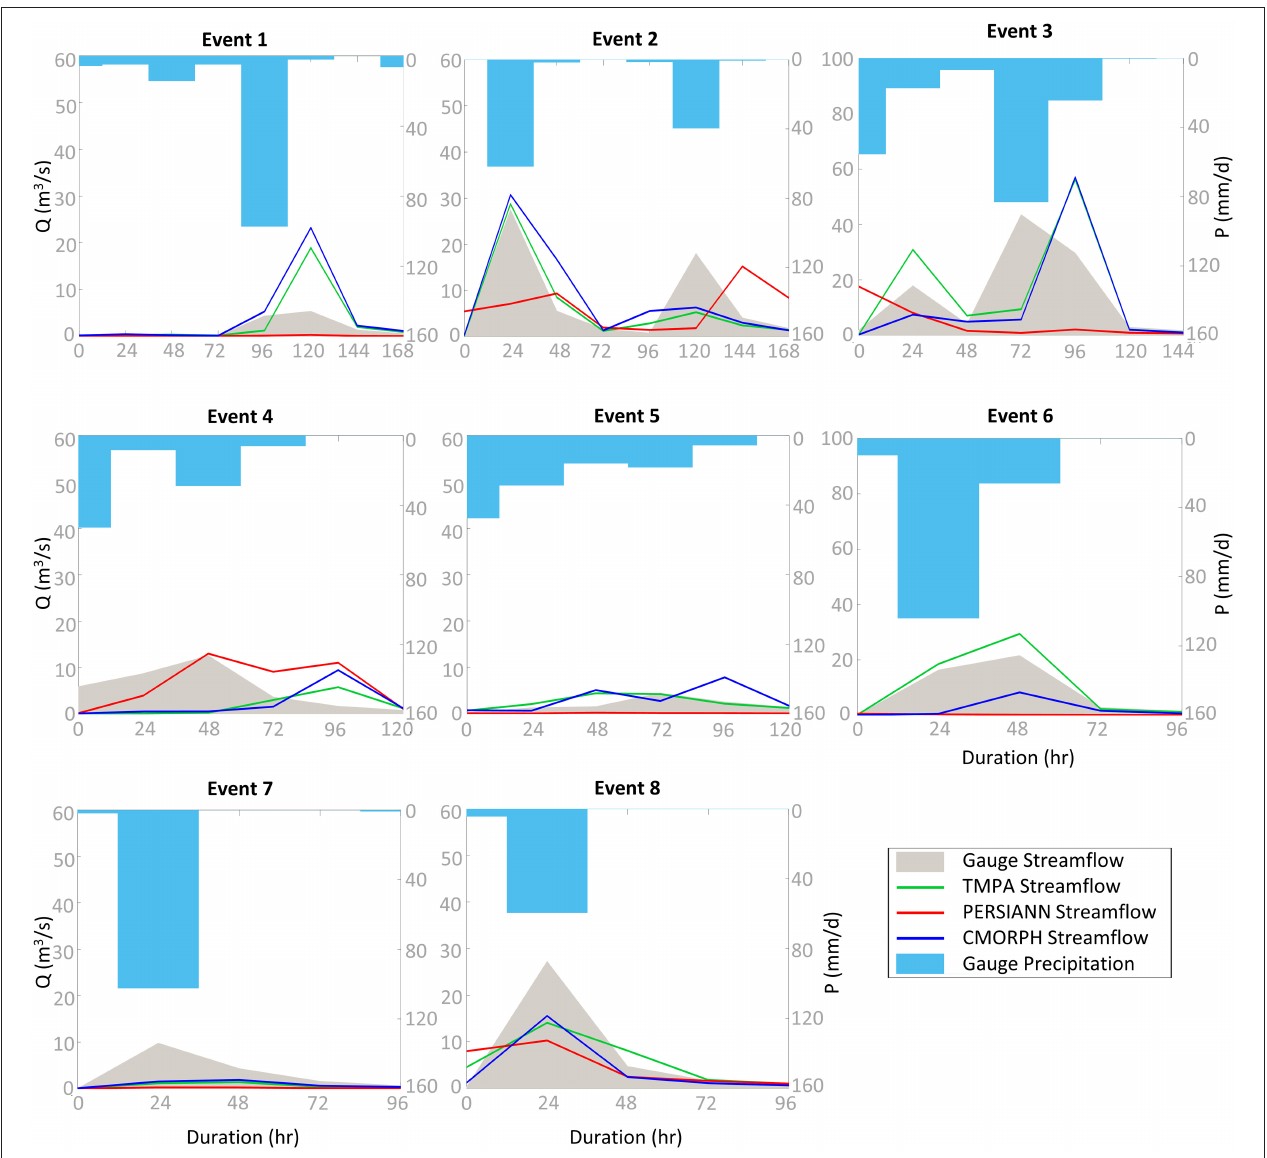
FIGURE 7 | Hyetograph of the eight hydrological extreme events based on observations of daily precipitation intensity (mm/day) at gauge EVGR and corresponding hydrographs of modeled streamflow (m 3 /s) for gauge-, TMPA-, CMORPH-, and PERSIANN-simulated data at evaluation point